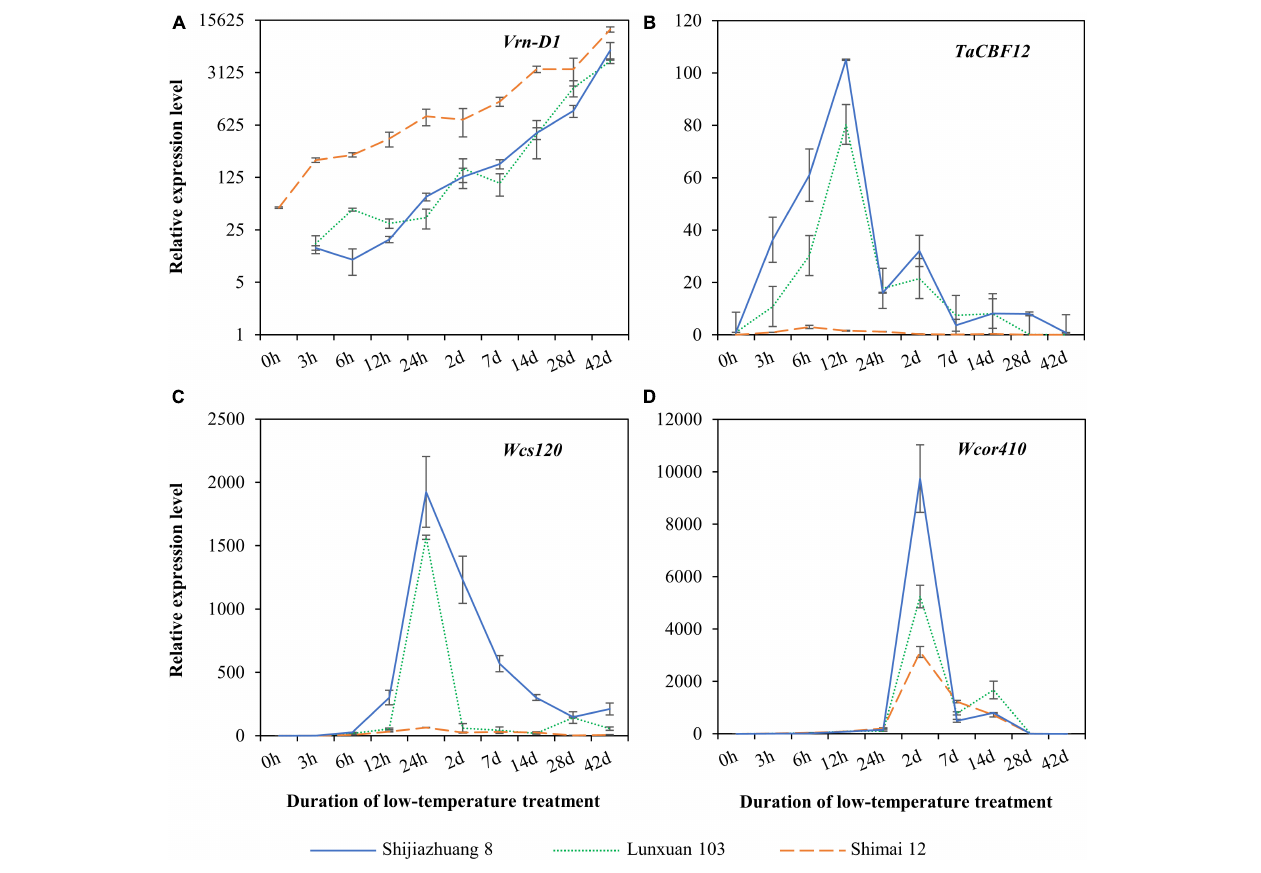
FIGURE 7 | Expression analysis of vernalization gene Vrn-D1 (A) and cold-responsive genes TaCBF12 (B) , Wcs120 (C) , and Wcor410 (D) in Lunxuan 103 and its parents Shijiazhuang 8 and Shimai 12.